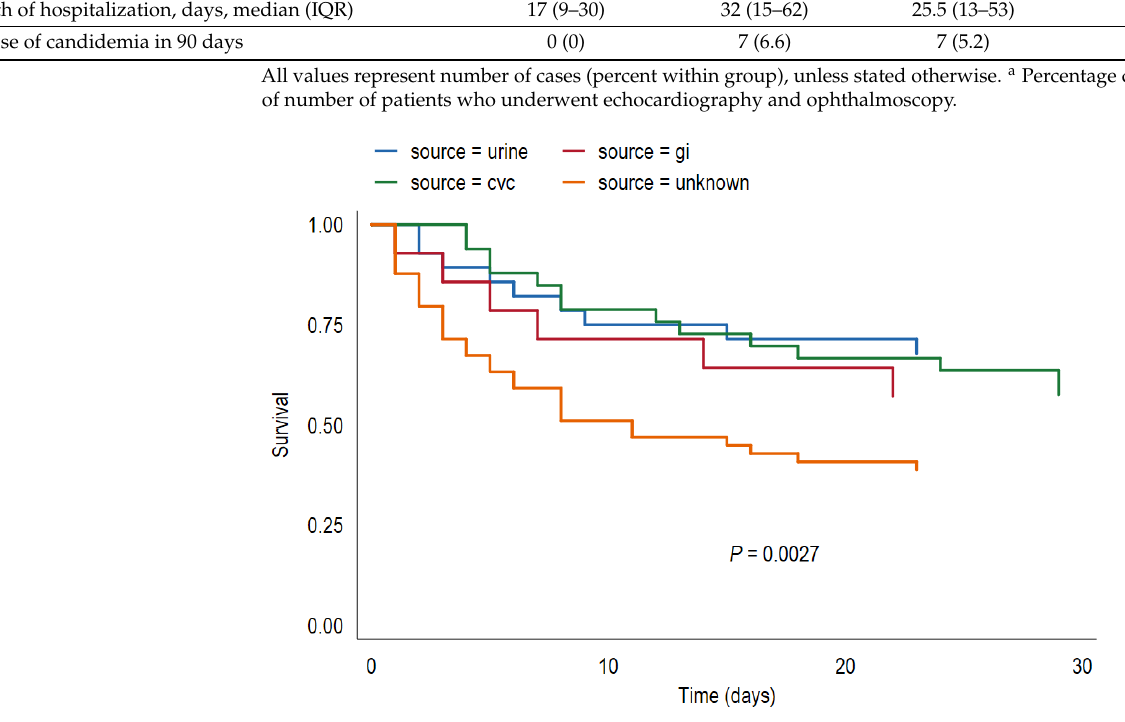
Figure 1. Survival analysis by source of candidemia Kaplan–Meier plot comparing the survival of patients with candidemia originating in the urinary tract (urine), central vascular catheter (cvc), gastrointestinal tract (gi) or an undetermined source (unknown). p value was calculated with the log-rank method for the comparison of all groups. Table 1. Characteristics of patients with Candida bloodstream infection of urinary and non-urinary origin.